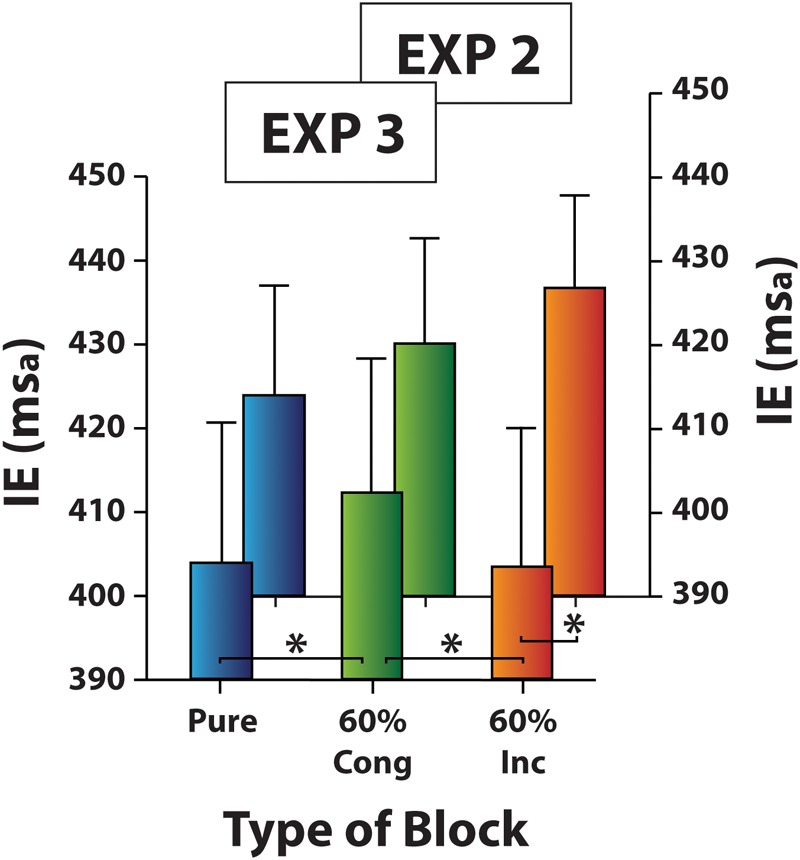
Experiment 3: Mean IE scores in Mixed blocks as a function of Type of Trial (distractor-absent, congruent distractor, and incongruent distractor), separately for 60% Cong block and 60% Inc block data. Results of Experiment 2 are also plotted on background for a comparison. Error bars represent the standard error of the means across participants. Asterisks mark significantly different mean/s.